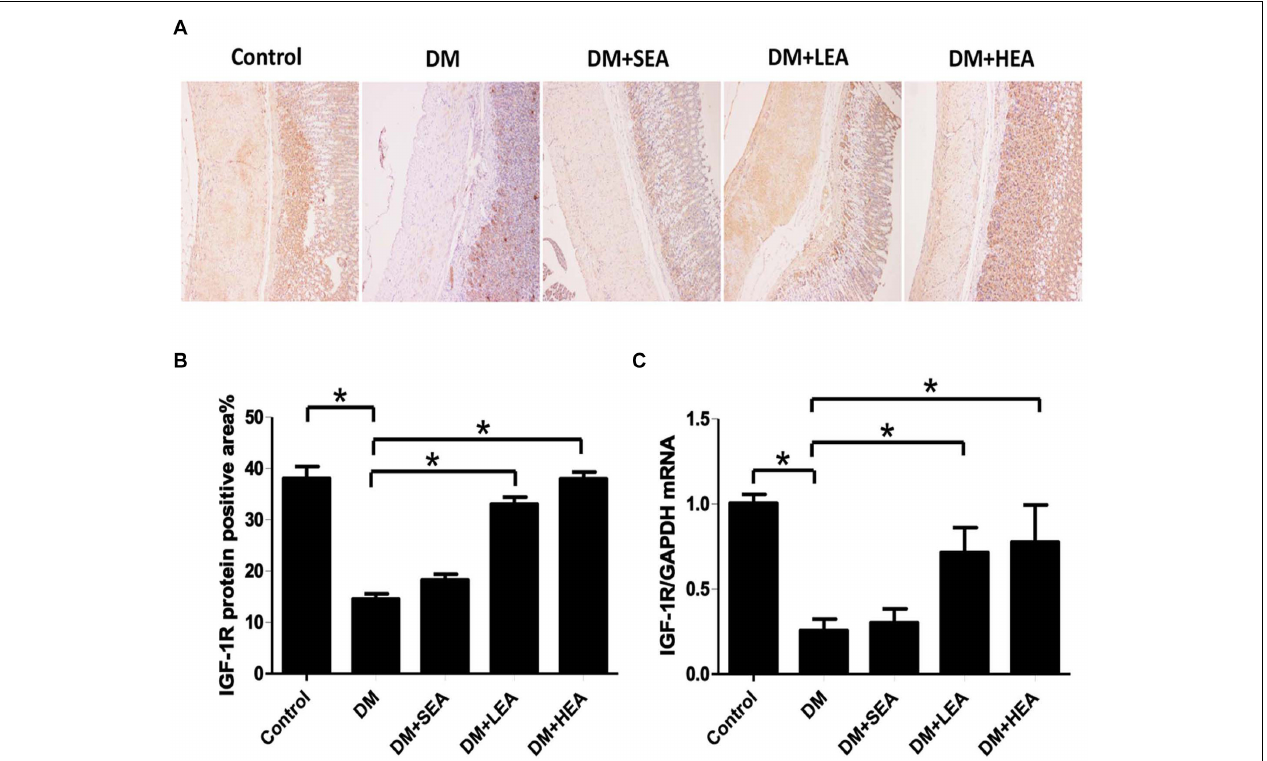
FIGURE 5 | The expression of IGF-1R in each group. (A) Immunohistochemical technique showed that lots of IGF-1R + cells in the control group, but in the DM and DM + SEA groups, there were few IGF-1R + cells distributed in the intramuscular layer (100 × ). The expression of IGF-1R + cells in the DM + LEA and DM + HEA groups was improved. (B) Quantification of IGF-1R expression in the stomach of each group. (C) RT-PCR revealed that the IGF-1R mRNA expression in the DM group was significantly decreased compared with that in the normal control group. In the DM + LEA and DM + HEA groups, expression of IGF-1R mRNA was increased compared with that in the DM group. One-way ANOVA was used to analyze the data of expression of IGF-1R protein and mRNA, and the LSD post hoc test was used for the analyses. * P < 0.05 compared with the DM